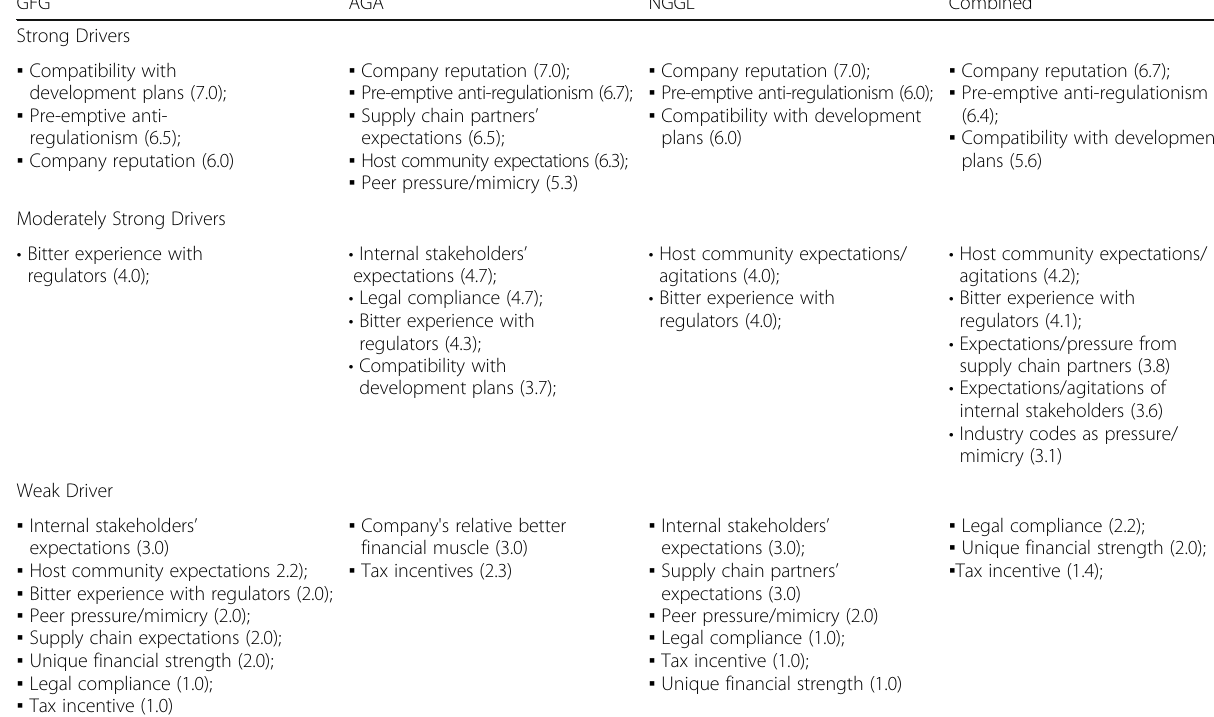
Table 3 Strengths of drivers of CSR involvement by case GFG AGA NGGL Combined Strong